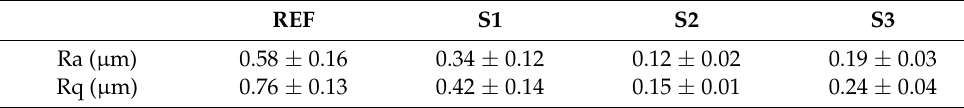
Table 3. Roughness parameters of different